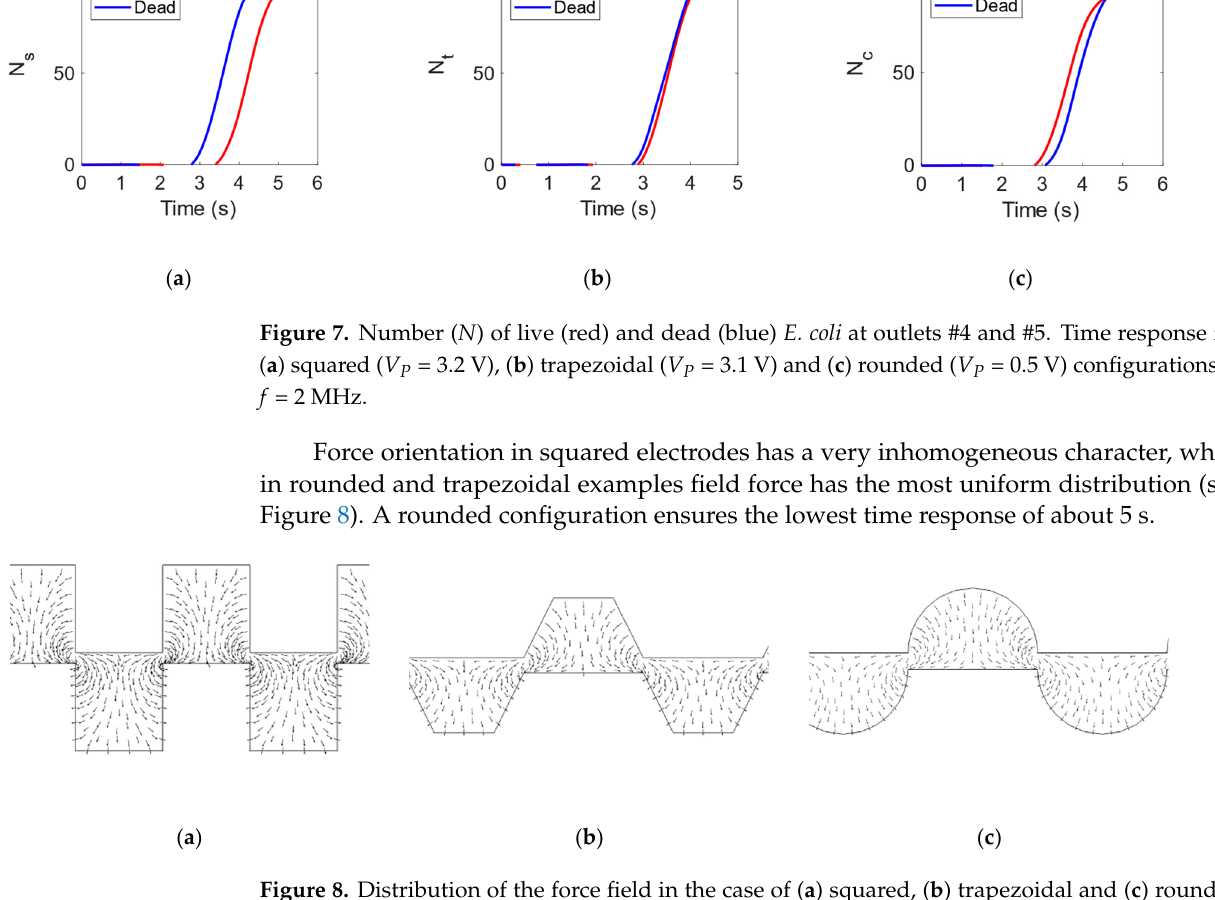
Figure 9. Proposed hybrid chip-scale platform formed by a micromixer channel (do tt ed red box) and a micro fl uidic channel with castellated electrodes (do tt ed green box). Inlets 1 and 2 are used to pump bacteria and antibiotics, respectively, while the outlets harvest the live (4) and dead (5) bacteria. Inlet 3 is used to pump the fl uid with a stripe velocity of 853 μ m/s.